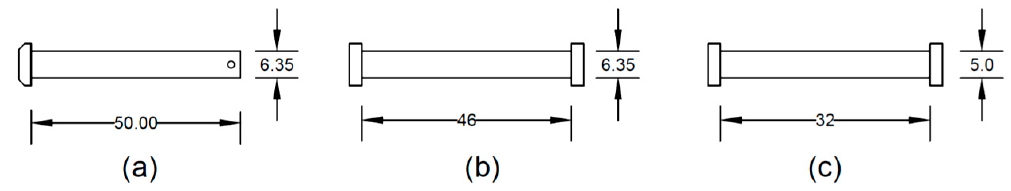
Figure 14. ( a ) Pin for connecting secondary bars at the apex point; ( b ) pin at the middle of the main link bar; and ( c ) Pin for sidebars.